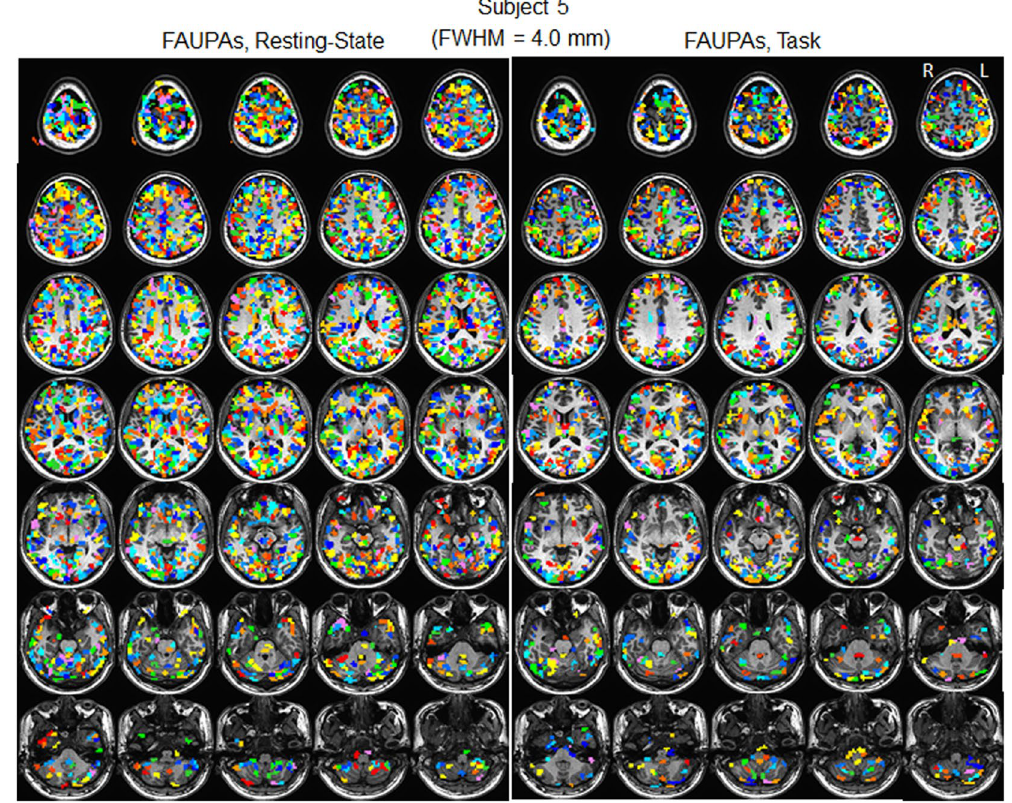
Figure 4. Illustration of the effect of spatial blurring with FWHM of 4.0 mm on the detected FAUPAs for subject 5. Each colored cluster with all connected voxels of the same color represents a FAUPA, and a total of 16 colors are used to differentiate these FAUPAs. Resting State: a total of 2192 FAUPAs; Task: a total of 1383 FAUPAs. L: left; R: